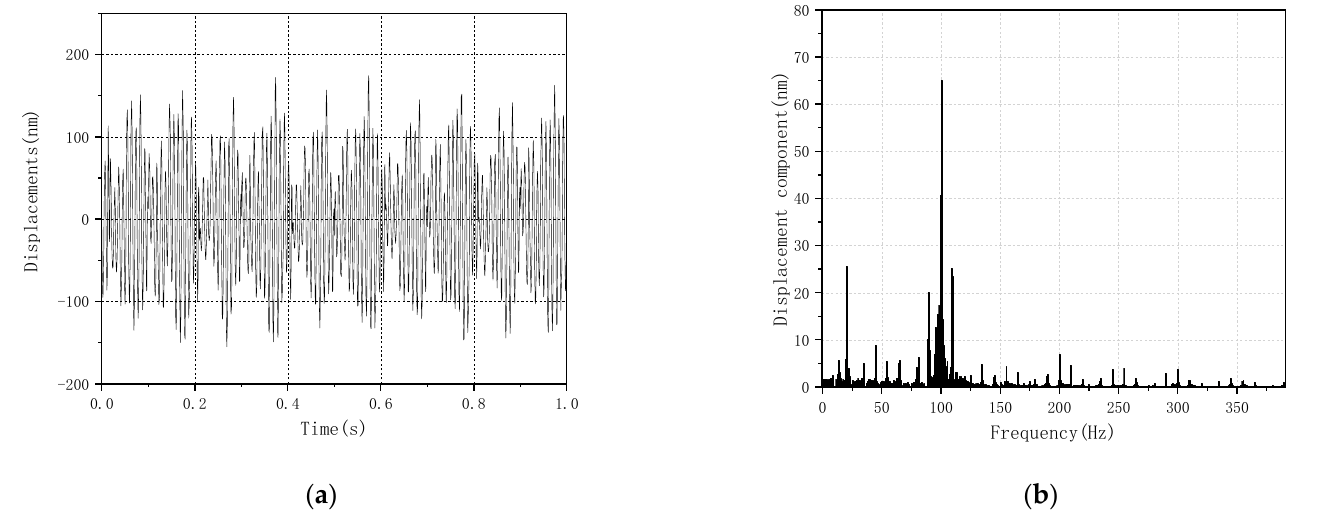
Figure 9. Vibration displacement of iron core with 5 Hz inter-harmonics in excitation; ( a ) time-domain waveform; ( b ) spectrum analysis. Table 3. Inter-harmonic frequency in vibration. Inter-Harmonic Frequency in Excitation (Hz) Inter-Harmonic Frequency in Vibration